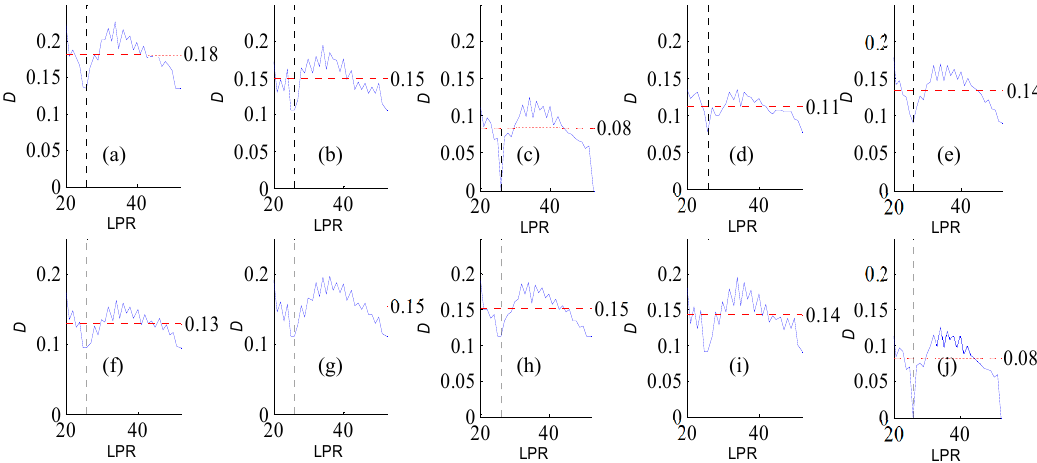
Figure A4. Variation of flow regime alteration degree (D) measured by the RVA with change in the